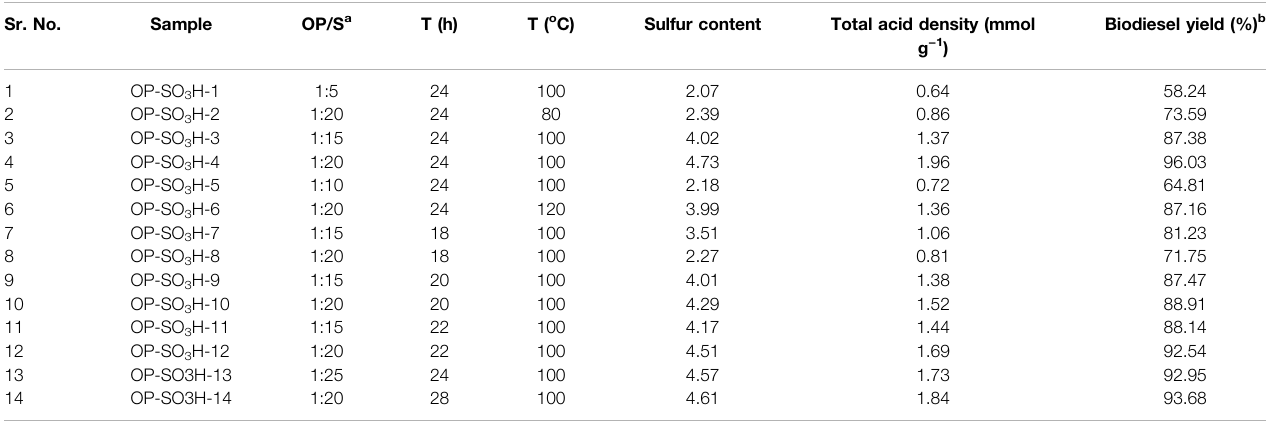
TABLE 1 | Catalysts were produced under various sulfonation circumstances and observed acid densities. Sr.